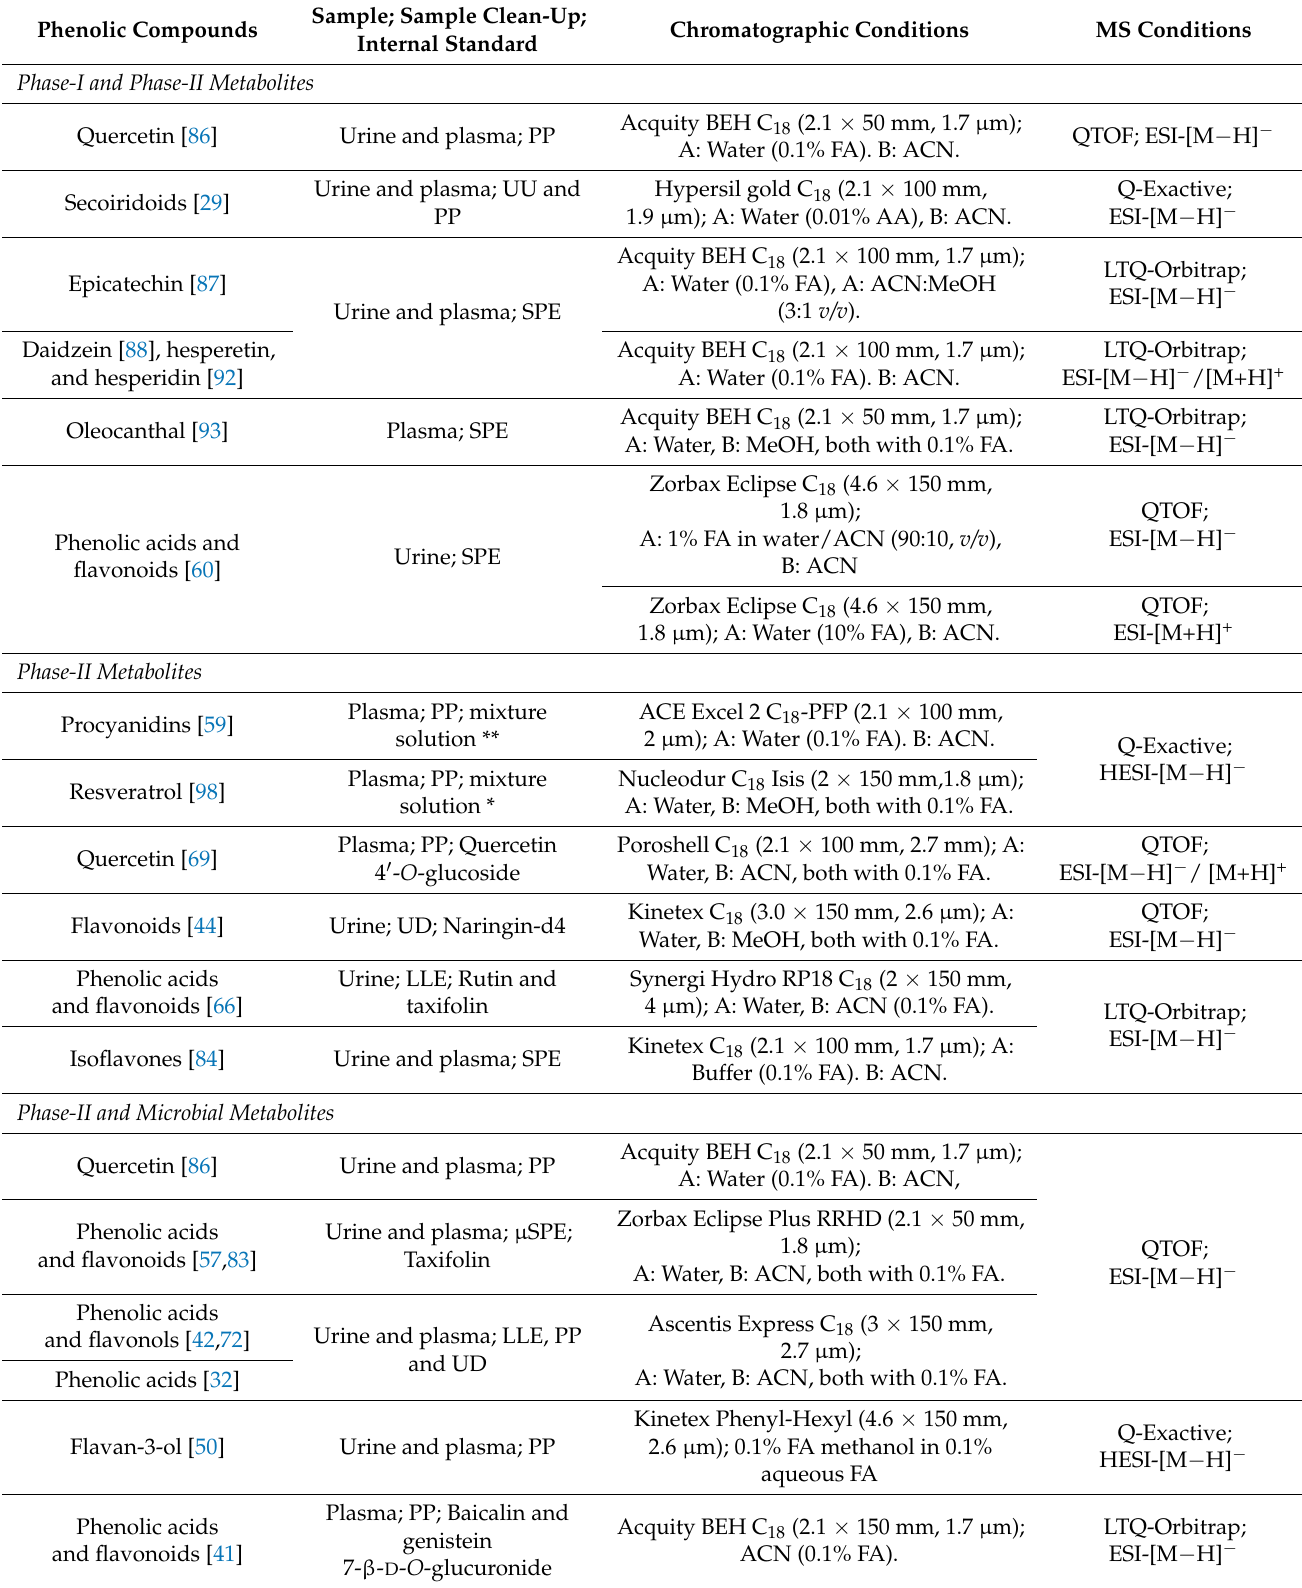
Table 2. Methods for untargeted analysis of PCM in urine and plasma